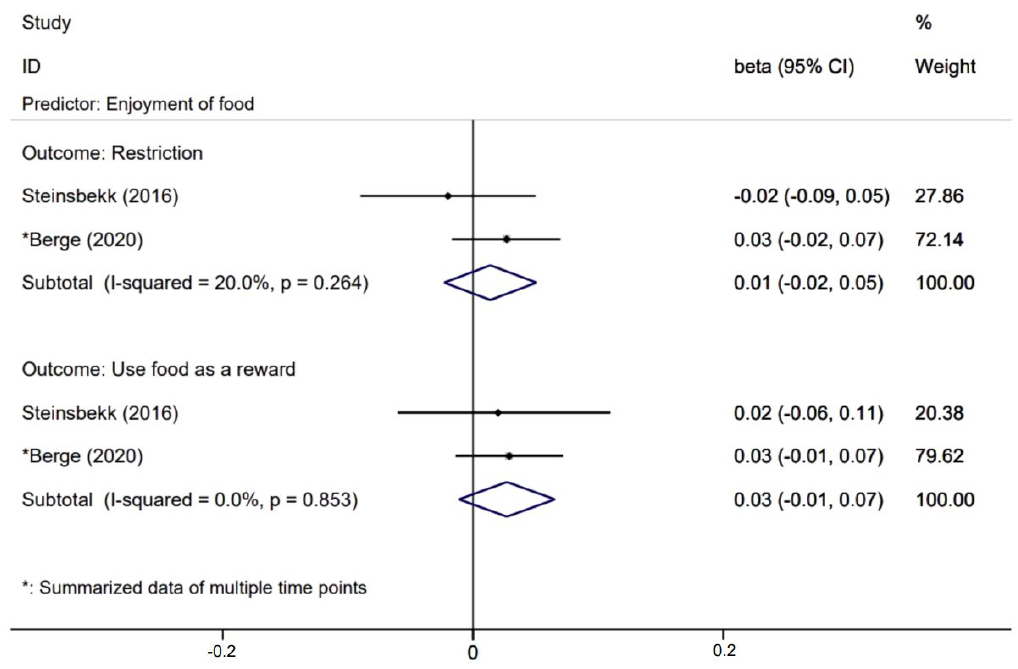
Figure 8. Effects of child enjoyment of food on parental non-feeding practices.